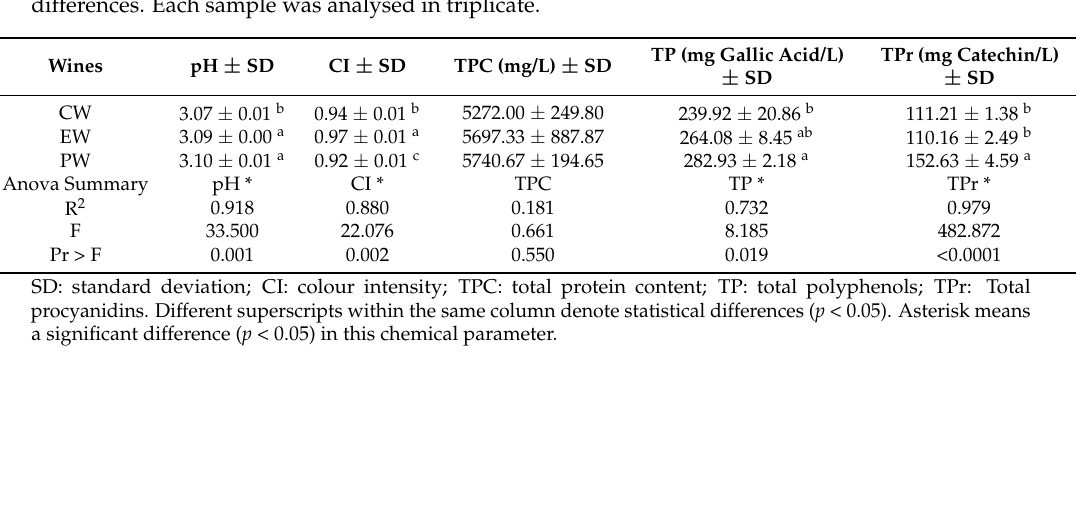
Table 1. Chemical composition (mean ± SD) of the three wines employed in this study. The table also shows the ANOVA and LSD-test results to compare the statistical significance of wine matrix differences. Each sample was analysed in